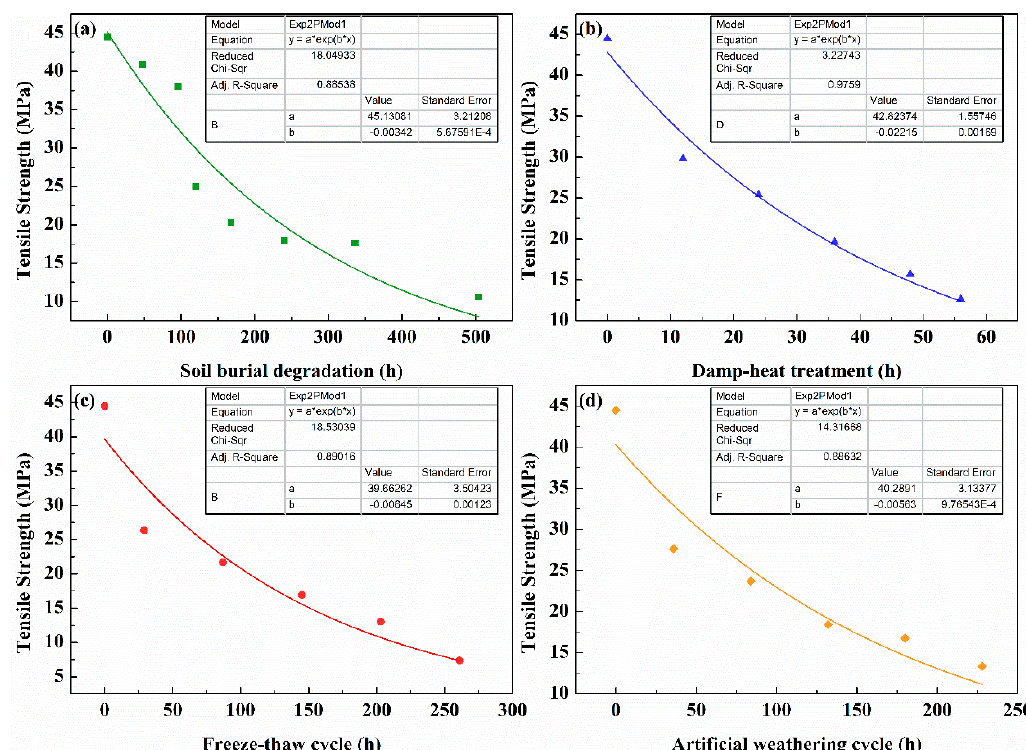
Figure 5. Fitting curves for different aging methods of bamboo fiber lunch boxes ( a ) soil burial degradation; ( b ) damp–heat treatment; ( c ) freeze–thaw cycle; and ( d ) artificial weathering cycle. Table 3. Relationship between soil burial degradation and accelerated aging